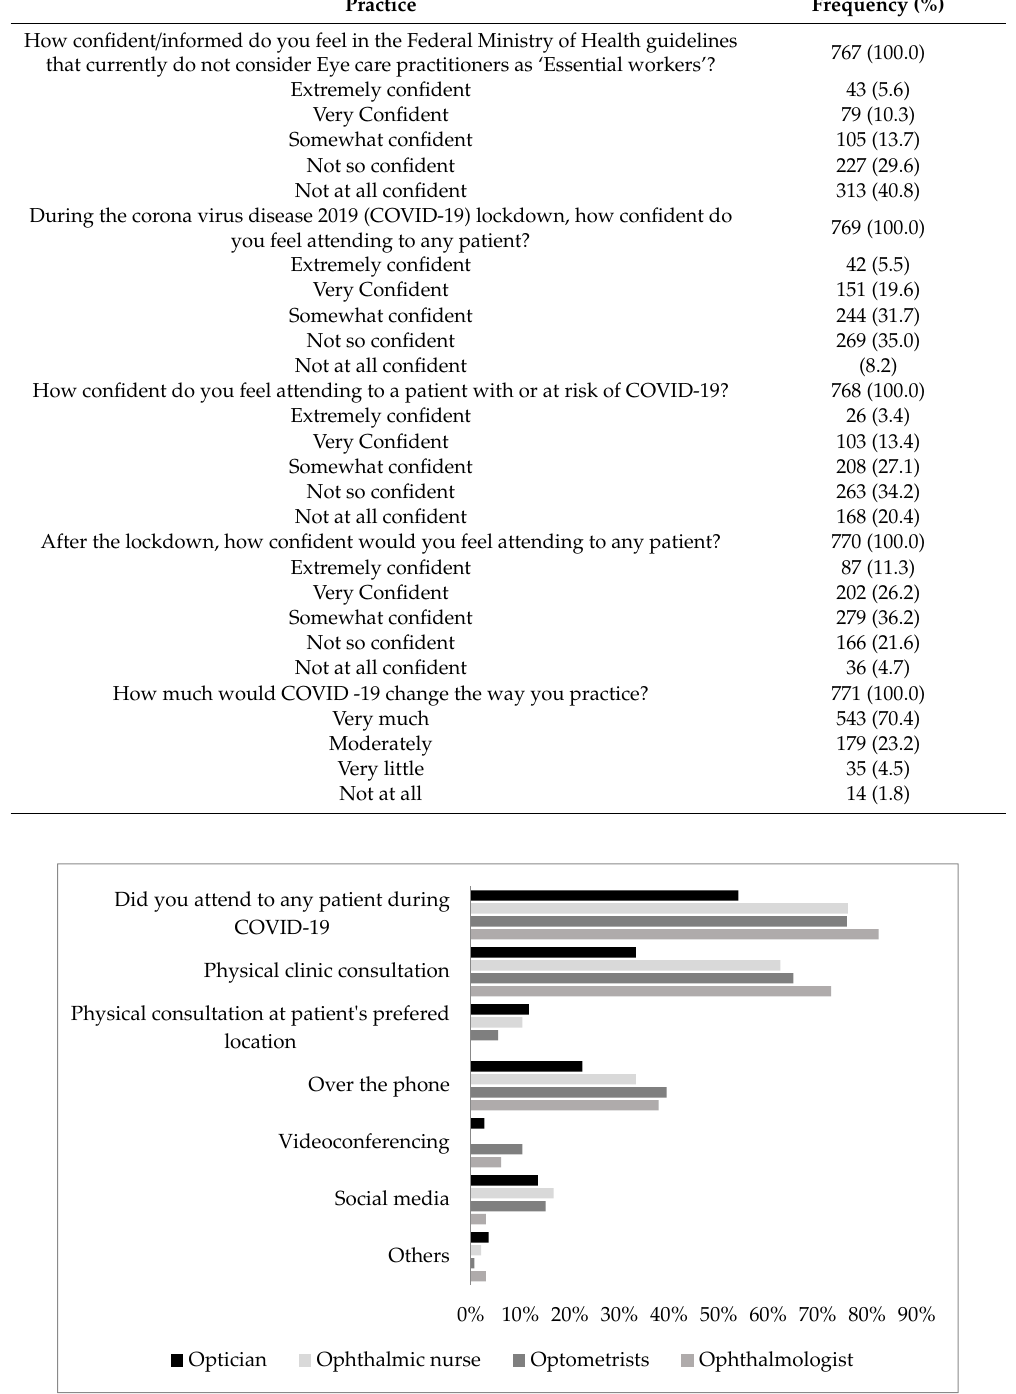
Figure 2. Provision of eye care services and the methods employed for the purpose by respondents during the novel coronavirus disease 2019 (COVID-19) lockdown.